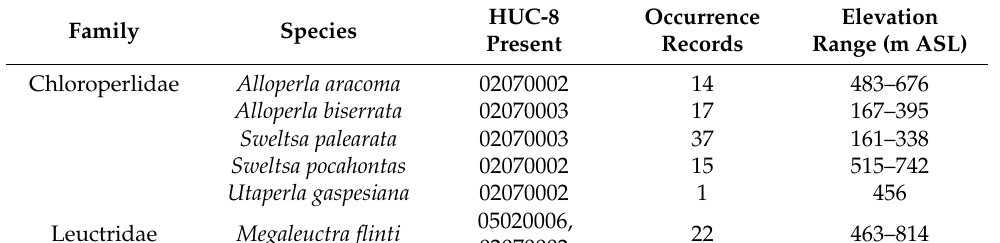
Table 13. Maryland Species of Greatest Conservation Need (SGCN)-listed stoneflies. USGS Hydro- logic Unit Code (HUC)-8 drainage basins where species are known to be present are noted in addition to the number of available Maryland records. Elevation data of unique collection localities within Maryland are provided per species.